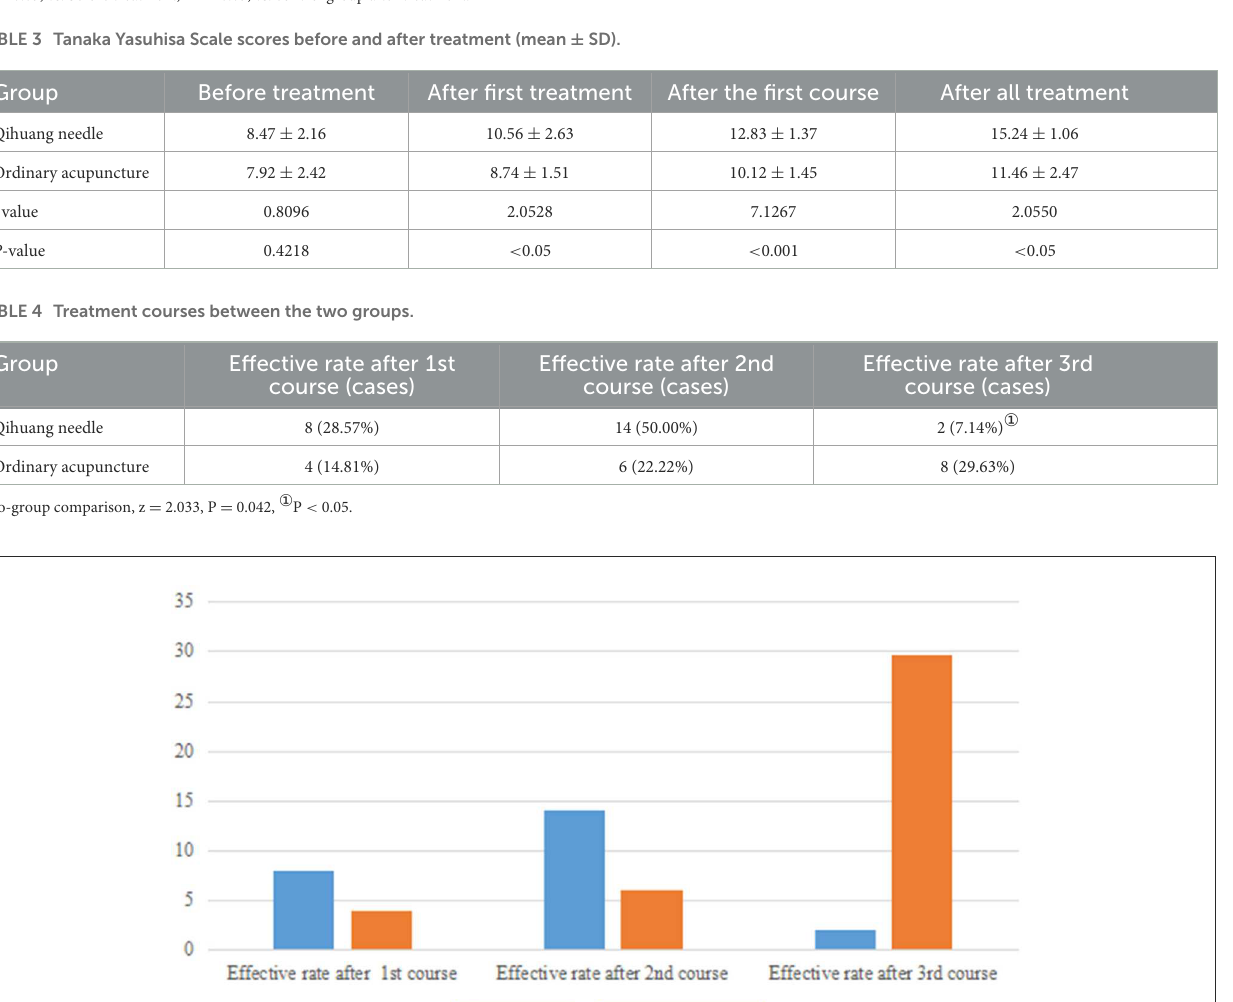
FIGURE1 A bar chart of treatment courses between the two groups.